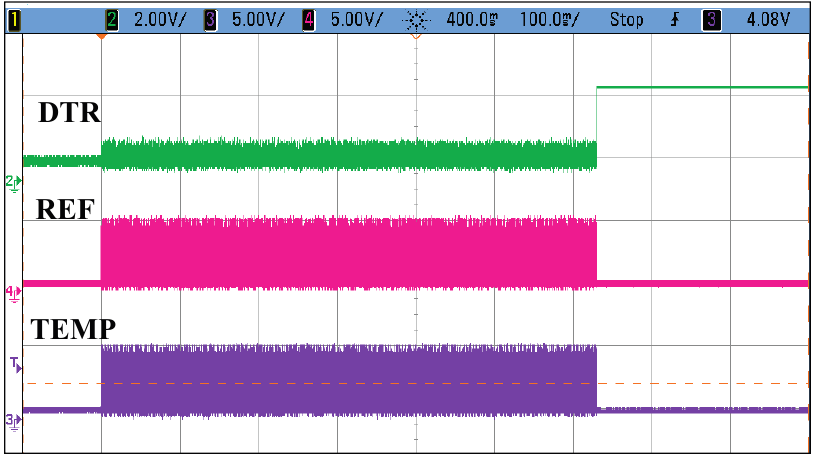
Figure 12. Oscillogram of the oscillator outputs. TEMP, temperature signal; REF, reference signal; DTR, data ready